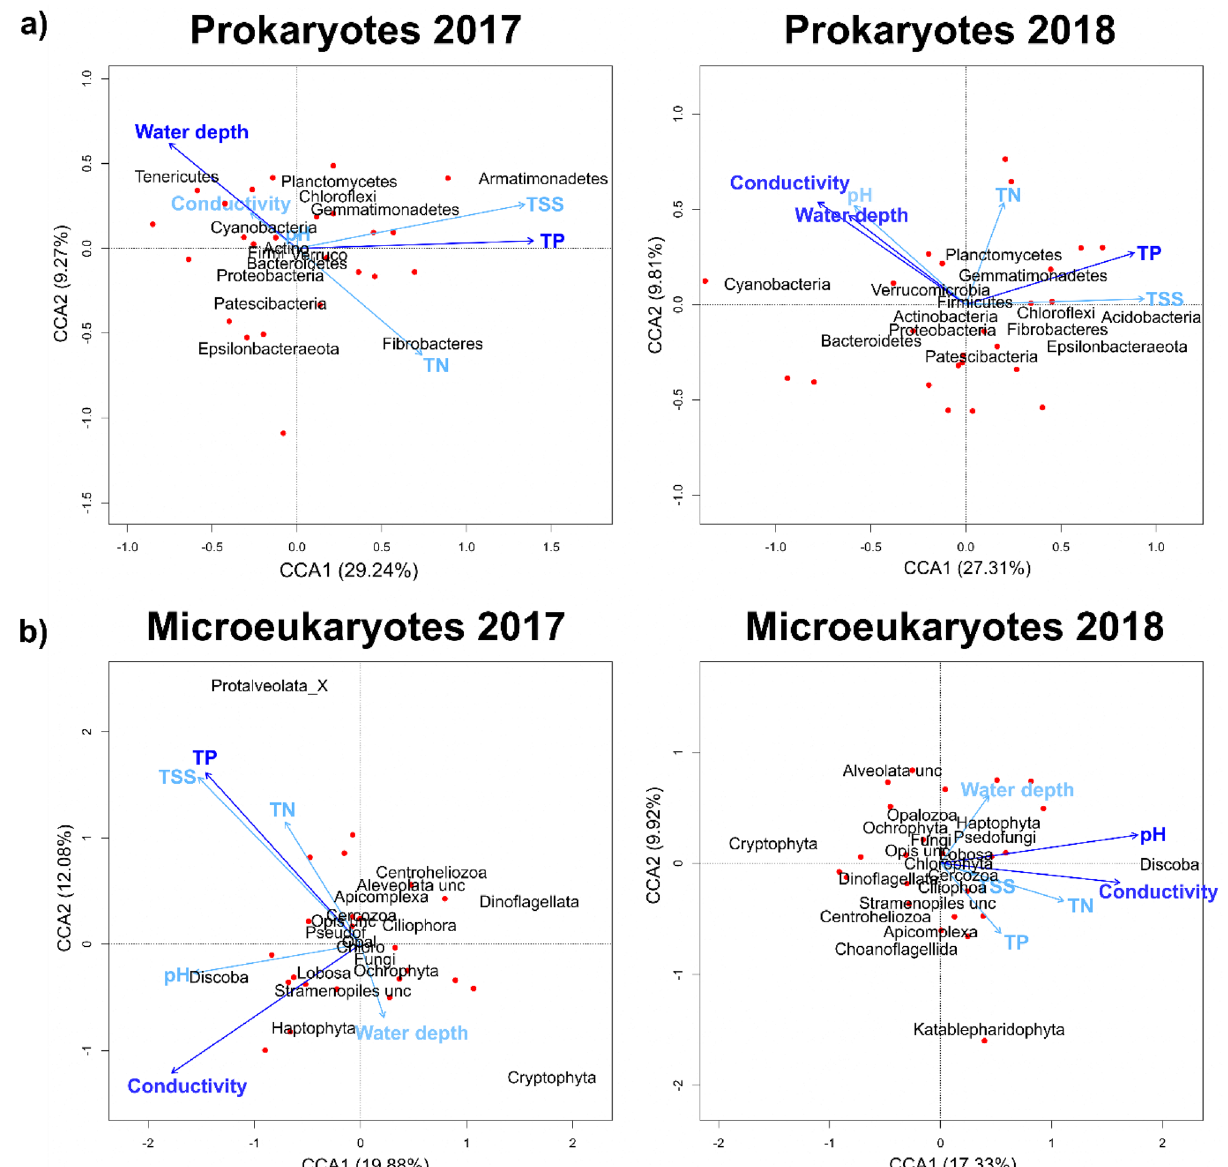
Figure 5. Canonical correspondence analysis (CCA) biplots based on the phylum composition of prokaryotes ( a ) and microeukaryotes ( b ) in the two years (red points: habitat scores, dark blue arrows: significant environmental variables, light blue arrows: all the other environmental variables). Abbreviation of the phyla names: unc = unclassified, Opis unc = Opisthokonta unclassified, Firmi = Firmicutes, Verruco = Verrucomicrobia, Actino = Actinobacteria, Chloro = Chlorophyta, Pseudof = Pseudofungi, Ochro = Ochrophyta, Opal = (Fig. S4), ciliates (richness with TSS, evenness with water depth) (Fig. S6), fungi (richness with pH) (Fig. S7), HF-HNF (evenness with TP) (Fig. S8), and phytoplankton (PD with conductivity and pH) (Fig. S9). Prokaryote richness (Bacteria and especially Cyanobacteria) was in general poorly explained by the envi- ronment (R 2 of the LMs of Bacteria: 0.175 in 2017 and 0.189 in 2018, R 2 of LM of Cyanobacteria: 0.141 in 2017 and 0.05 in 2018), and no significant predictor was identified for either group in 2018. In general, environment explained a higher variation in richness in 2017 than in 2018 in all microeukaryotic groups and in Cyanobacteria (based on R 2 values of the models, Fig. 6).